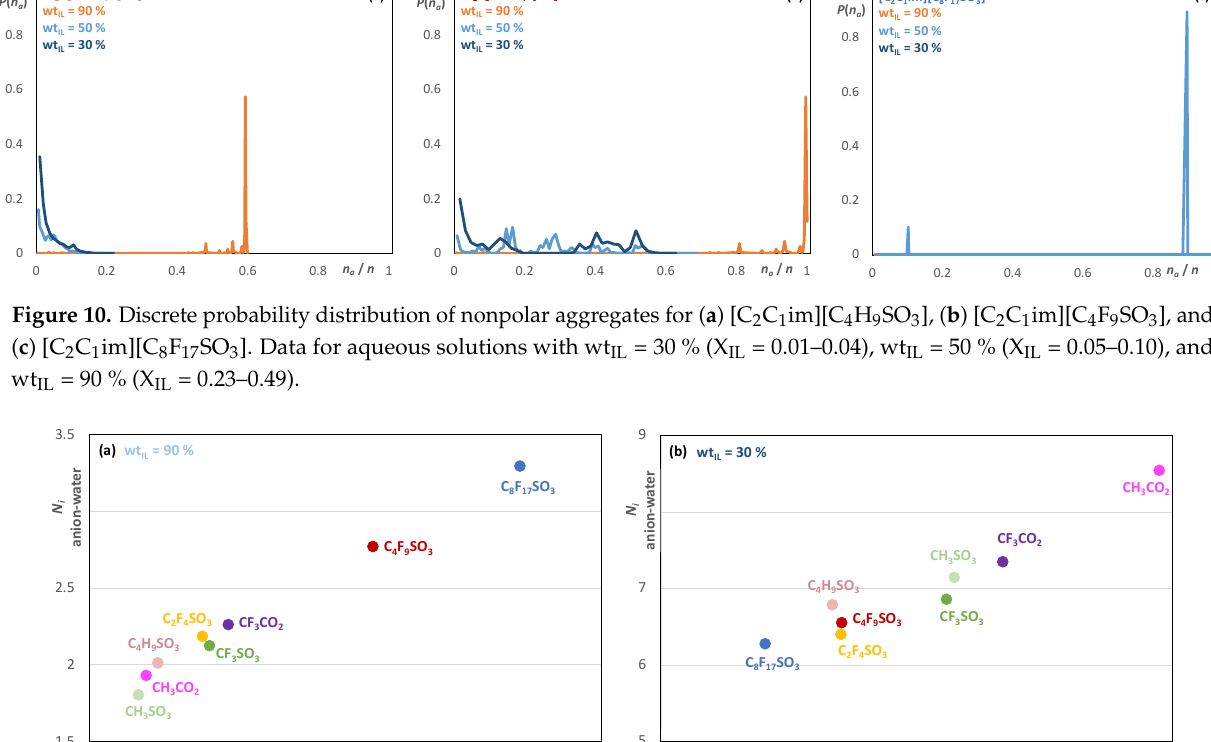
Figure 11. Average number of water neighbors around the cation vs. the anion for the C 2 C 1 im C n F 2 n +1 SO 3 , C 2 C 1 im C n H 2 n +1 SO 3 , C 2 C 1 im CF 3 CO 2 , and C 2 C 1 im CH 3 CO 2 at ( a ) wt IL = 90 (X IL = 0.23–0.49) and ( b ) wt IL = 30 % (X IL = 0.01–0.04). The length and nature (hydrogenated versus fluorinated) of the alkyl side chains play a similar role in the water solvation process: at modest water concentrations (wt IL = 0.9; X IL = 0.23–0.49), the existence of longer and more fluorinated chains leads to more interac- tions between water molecules and the polar network (as we have discussed before, C 2 C 1 im C 8 F 17 SO 3 is the first to lose the integrity and continuity of its polar network and start the formation of large polar network clusters); at higher water concentrations (wt IL = 0.3; X IL = 0.01–0.04), the existence of nonpolar aggregates (more pronounced in longer and fluorinated chains) leads to relatively low numbers of water–ion interactions (disruption in C 2 C 1 im C 8 F 17 SO 3 starts earlier but proceeds at a slower pace). The spatial distribution functions, SDFs, for selected atoms around the [C 2 C 1 im] + cat- ion for IL aqueous solutions with wt IL = 0.9 and 0.3 in the [C 2 C 1 im][C n F 2 n +1 SO 3 ], Figure 12. Results for wt IL = 0.5 (X IL = 0.05–0.10) are presented in Figures S6–S9 of the Sup- plementary Materials. The patterns of interaction of the sulfonate ions and water mole- cules around the imidazolium cations are strikingly similar for each concentration. It must be stressed that the isodensity surface plots do not show how high the density is inside each contour; they only provide a spatial overview of the locations of the most probable interactions. At wt IL = 0.9 (X IL = 0.23–0.49), both the fluorinated and hydrogenated R-SO 3− anions are in clear competition with water molecules for the acidic hydrogens at the C2 and C4 positions of [C 2 C 1 im] + . The anions are gradually displaced from these preferred coordination sites as the amount of water increases, in line with the observed shifts of the